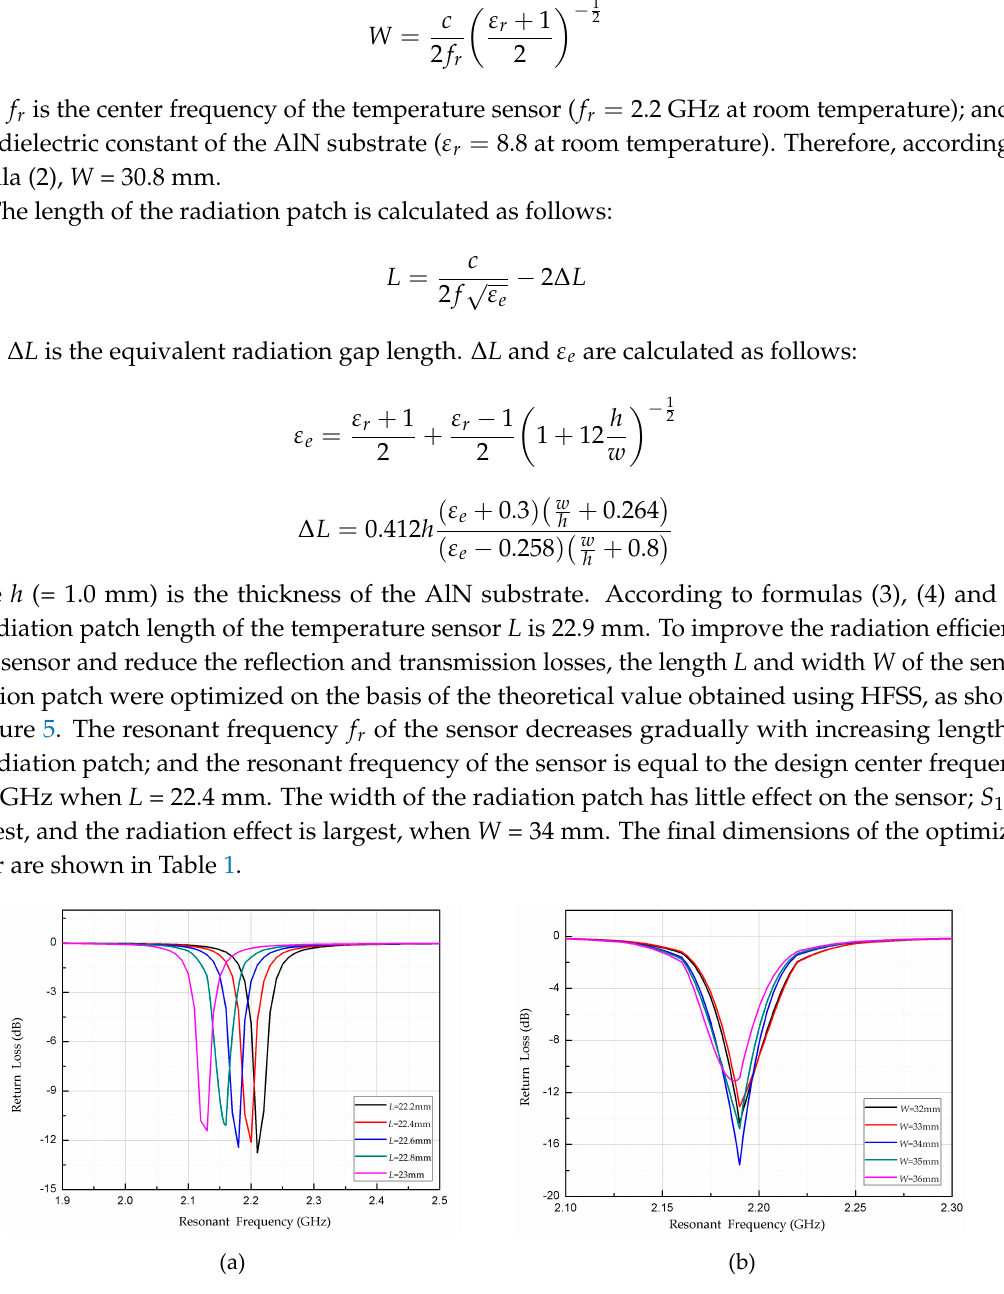
Figure 5. High-frequency simulator structure (HFSS) simulation results: (a) length L ; and (b) width W of radiation patch.